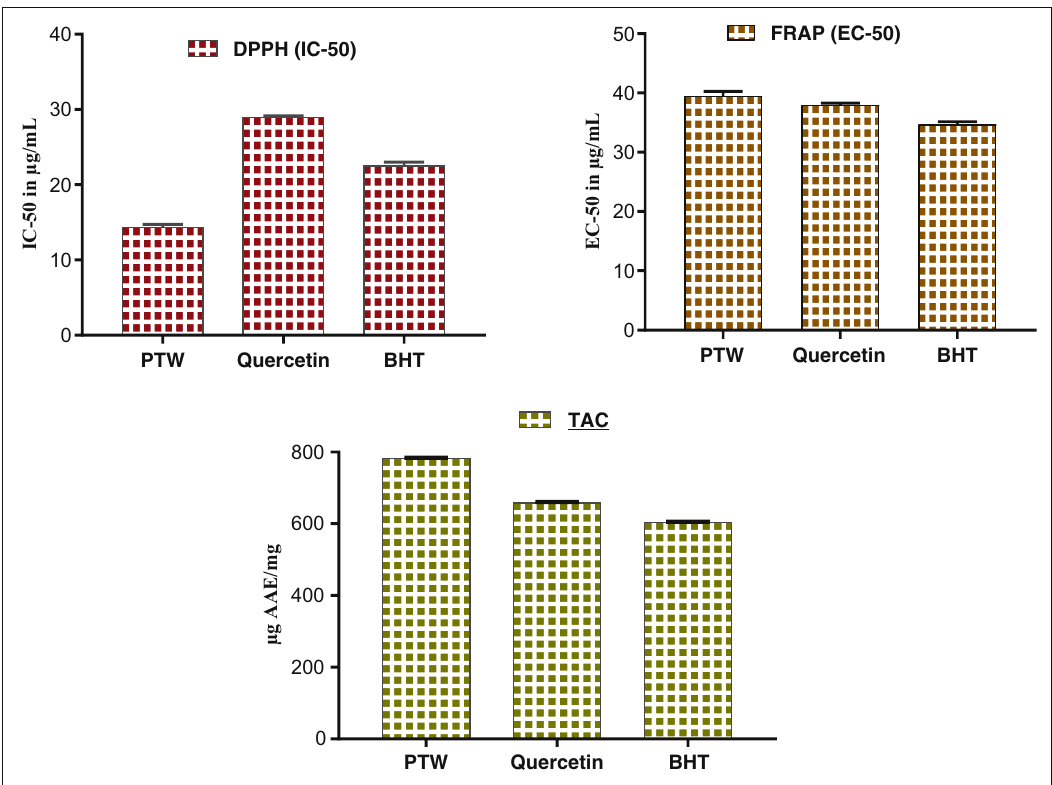
Figure 3: Antioxidant activities of polyphenol - rich fraction from the leaves of Withania adpressa Coss. ex